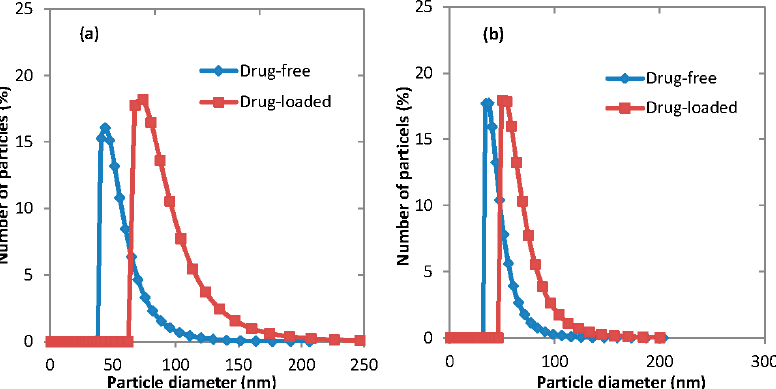
Figure 9. The particle size distribution of empty and drug-loaded micelles prepared using two different devices: ( a ) Microfludic; and ( b ) Membrane. For drug-free micelles, the organic phase concentration was 1 mg·mL − 1 PEG- b -PCL (B) in acetone. For drug-loaded experiments, the organic phase was a mixture of 0.6 mg·mL − 1 fluconazole and 1.5 mg·mL − 1 PEG- b -PCL (B) in acetone. The aqueous/organic phase ratio was Q a /Q o = 0.71.